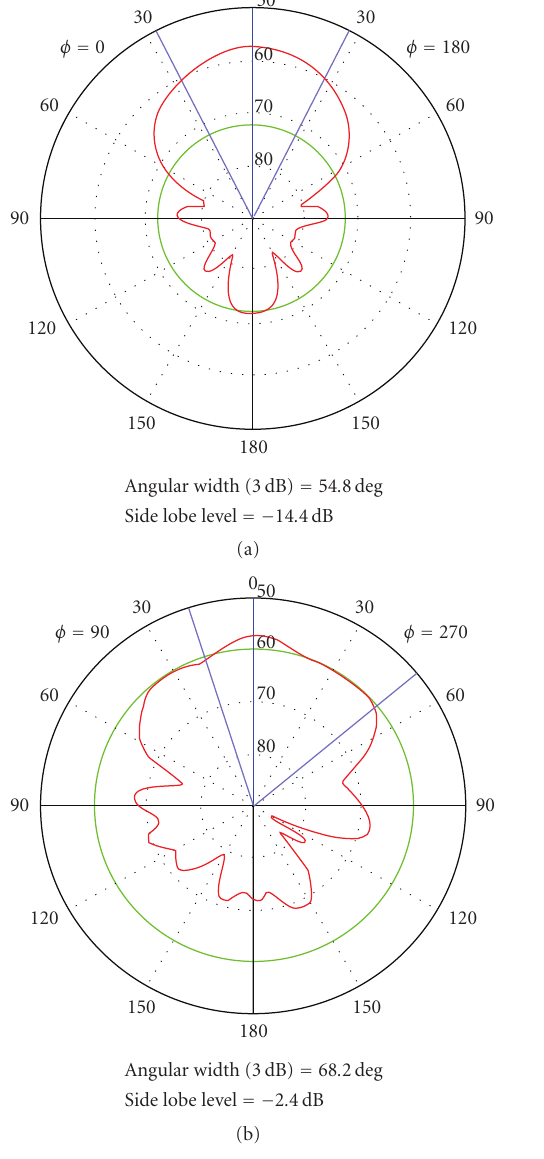
Figure 7: P-field along (a) H-plane (b) E-plane.